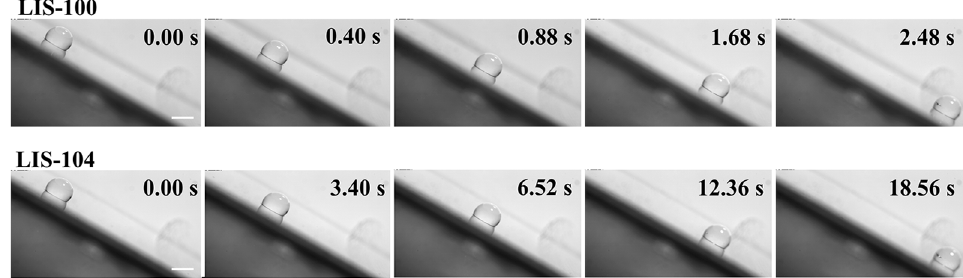
Figure 9. Time-lapsed images of a water droplet sliding on the inclined surfaces (inclination angle, 30°). The scale bar is 2